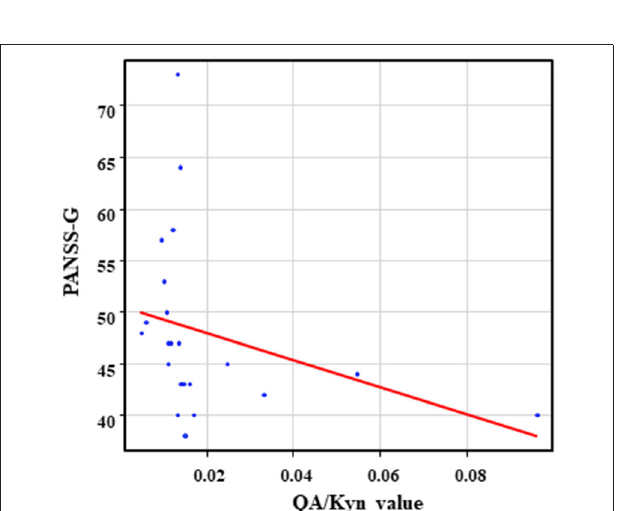
FIGURE 9 | Association between the PANSS-G scores and the QA/Kyn value in the schizophrenia group. A negative correlation was found between the PANSS-G score and the QA/Kyn value ( r = − 0.64, p = 0.0014) in the schizophrenia group.